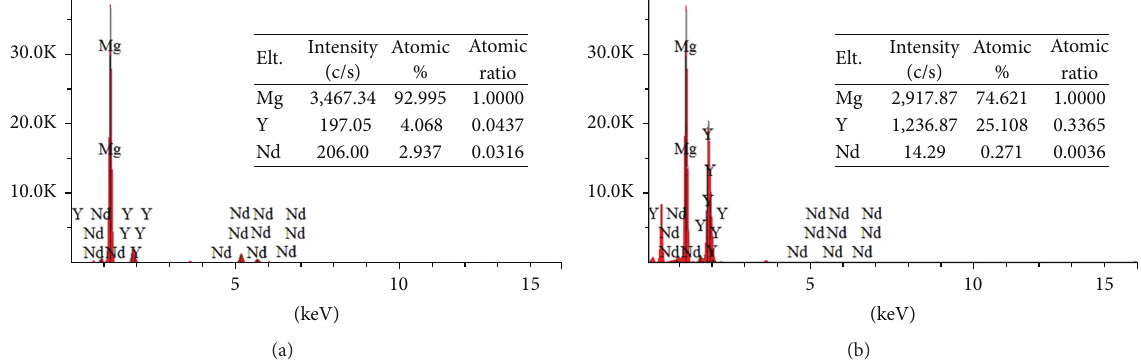
Figure 2: The EDS results of different precipitations in as-cast Mg-5Y-1.5Nd alloy: (a) Mg 12 (Y,Nd) and (b) Mg 3 (Y,Nd).